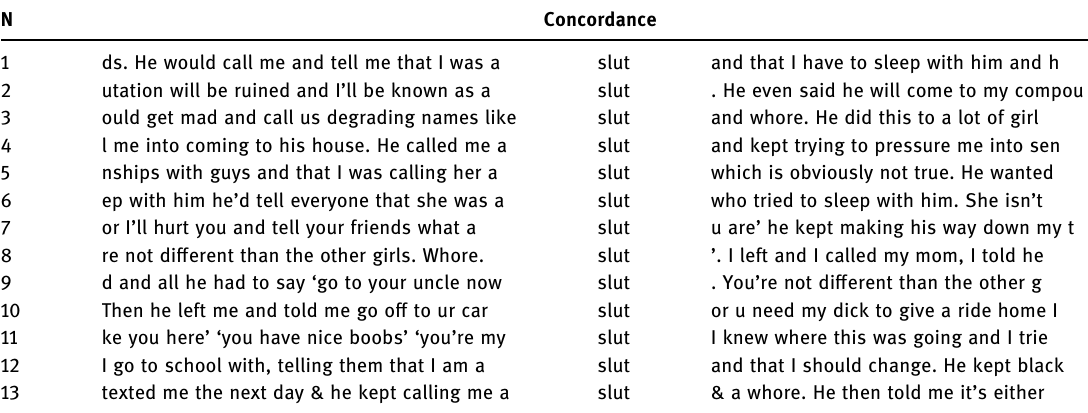
Table 21: Concordance lines for slut